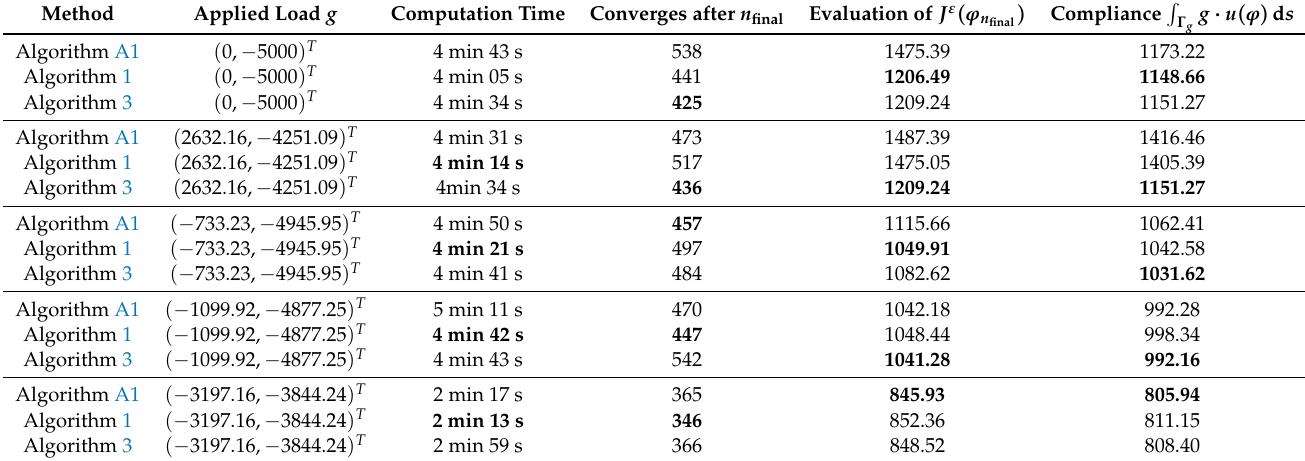
Table 4. Comparison of metrics between Algorithms A1, 1 and